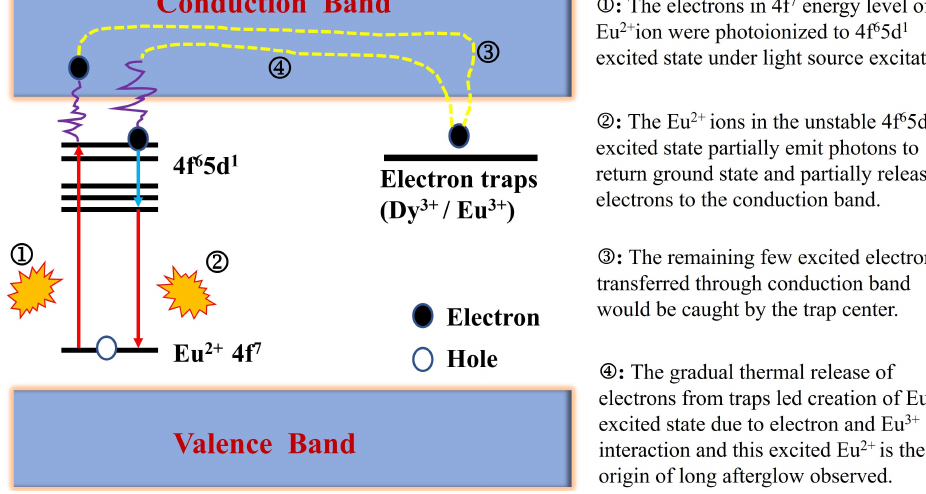
Figure 9. Schematic diagram of afterglow mechanism for SrAl 2 O 4 : Eu 2+ , Dy 3+ .